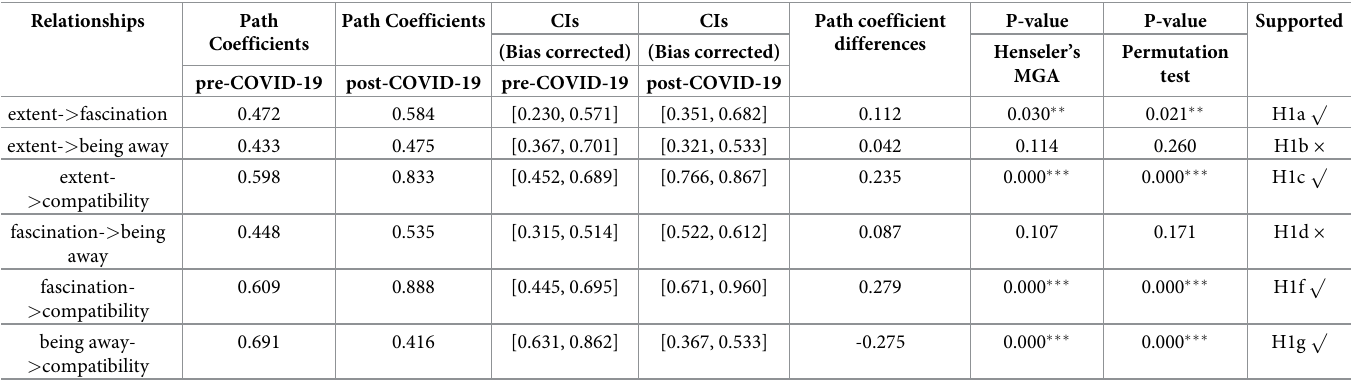
Table 3. Results of